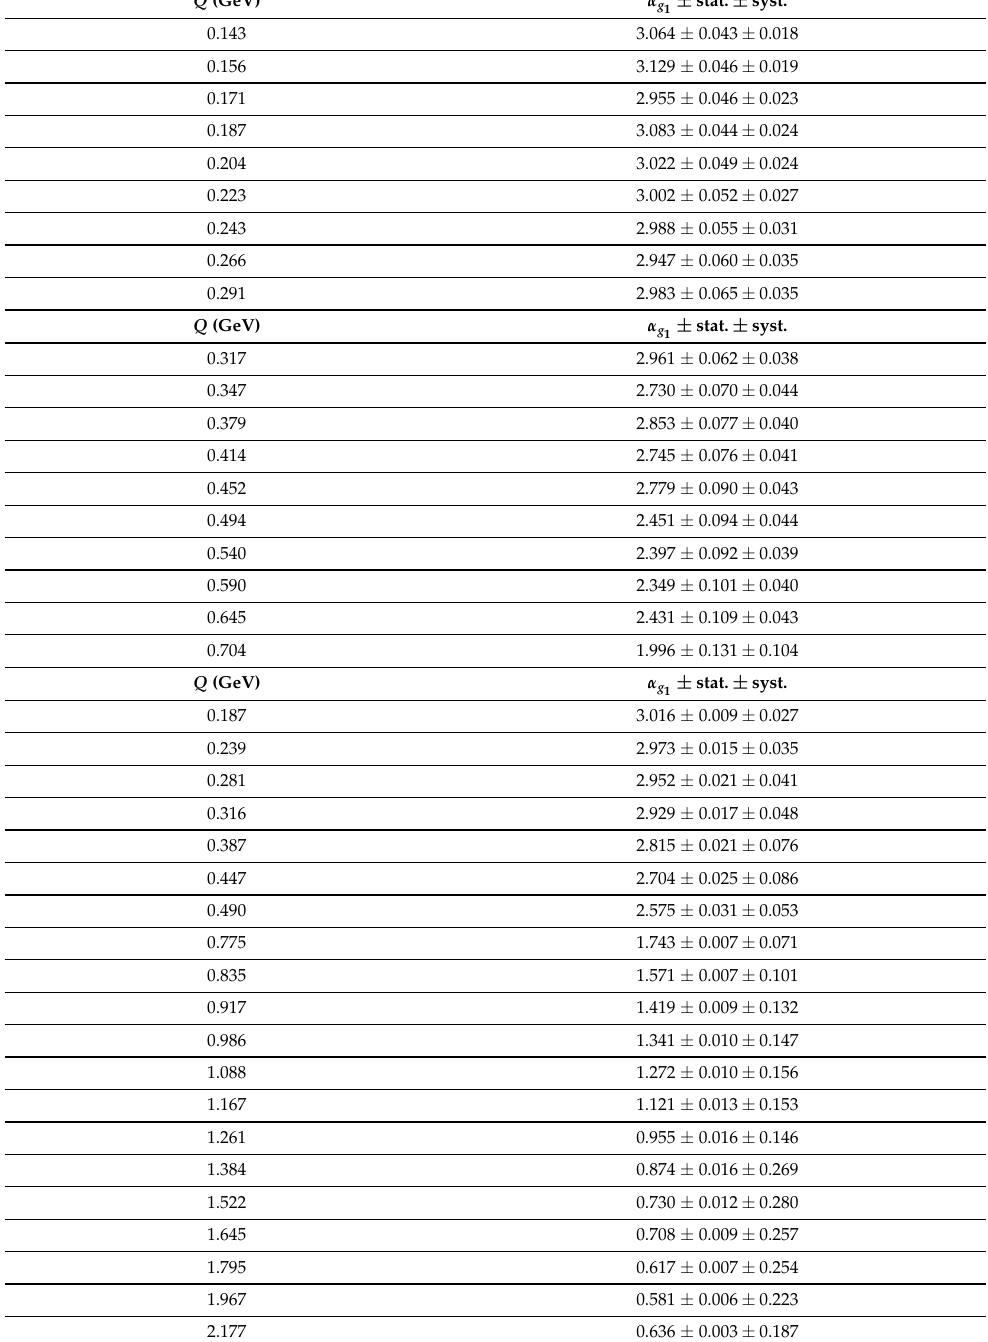
( Q ) from JLab experiments EG4 (top, from Q = 0.143 GeV to 0.704 GeV), Table 1. Data on α g 1 EG4/E97110 (middle, from Q = 0.187 GeV to 0.490 GeV) and EG1dvcs (bottom, from Q = 0.775 GeV to 2.177 GeV). Q (GeV) α g